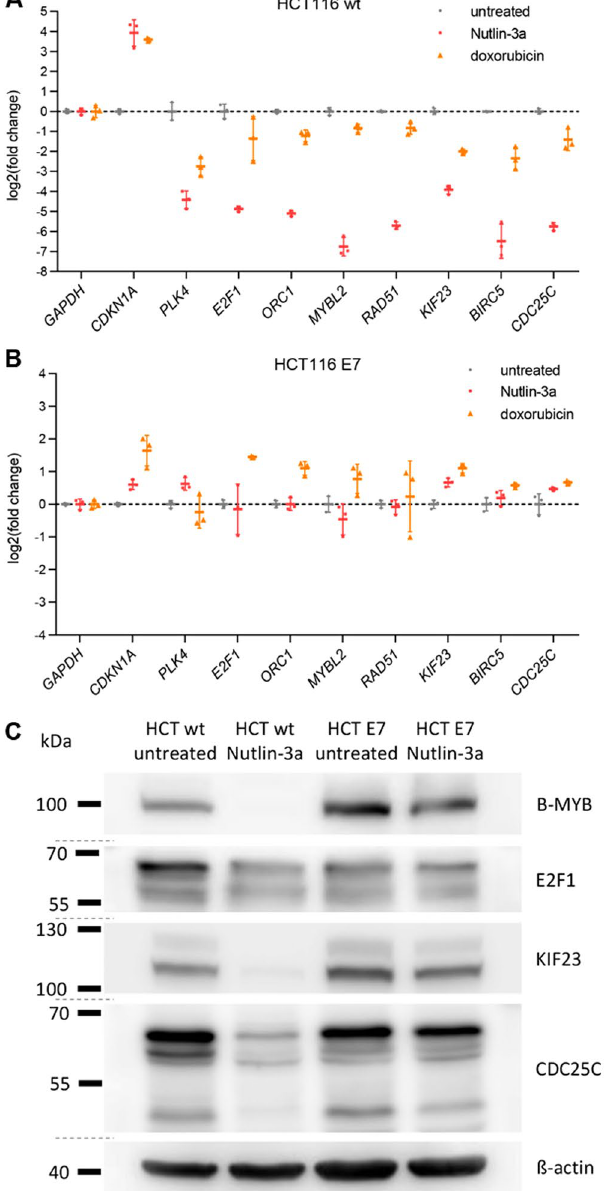
Figure 1. HPV E7 abrogates p53-mediated downregulation of DREAM target genes. ( A ) HCT116 wild-type and ( B ) HCT116 HPV E7-expressing cells were treated with Nutlin-3a or doxorubicin for 24 h. Untreated cells served as control. Semiquantitative RT-PCR was performed. The log 2-fold change of mRNA expression of treated compared to untreated cells is displayed. GAPDH served as a negative control for the p53 response, while p21 (CDKN1A) and PLK4 were tested as positive controls. ( C ) HCT116 wild-type and E7-expressing cells were treated with Nutlin-3a for 24 h or left untreated. Protein levels were analyzed through immunoblotting and ß-actin levels served as loading control. Cropped blot images are displayed; full images are included in Supplementary Figure